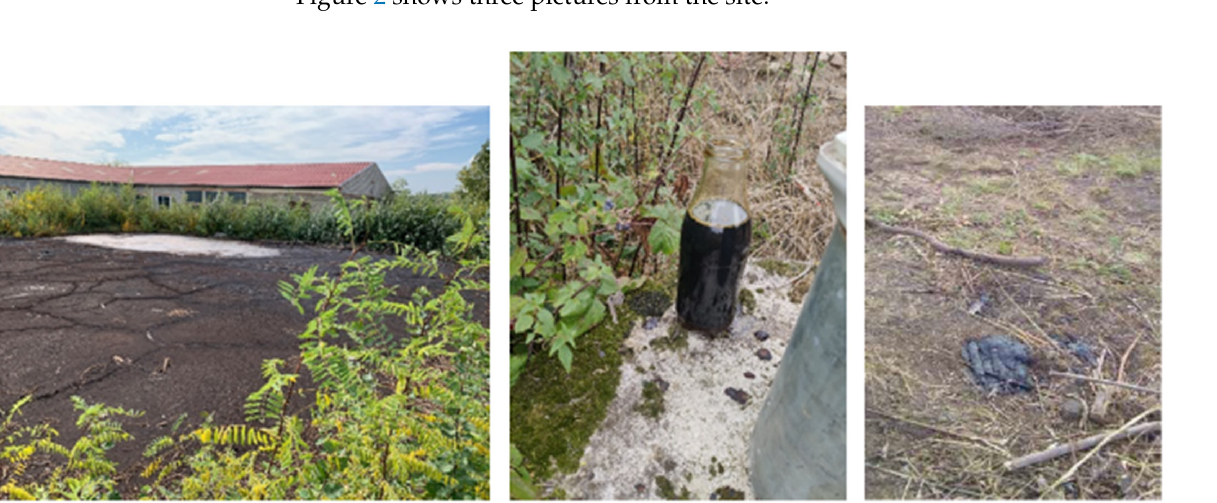
Figure 2. The brownfield “N77” in Droesing, Lower Austria. Left : the acid tar lagoon. Middle : oil that was pumped from the groundwater. Right : acid tar bubble seeping to the surface.